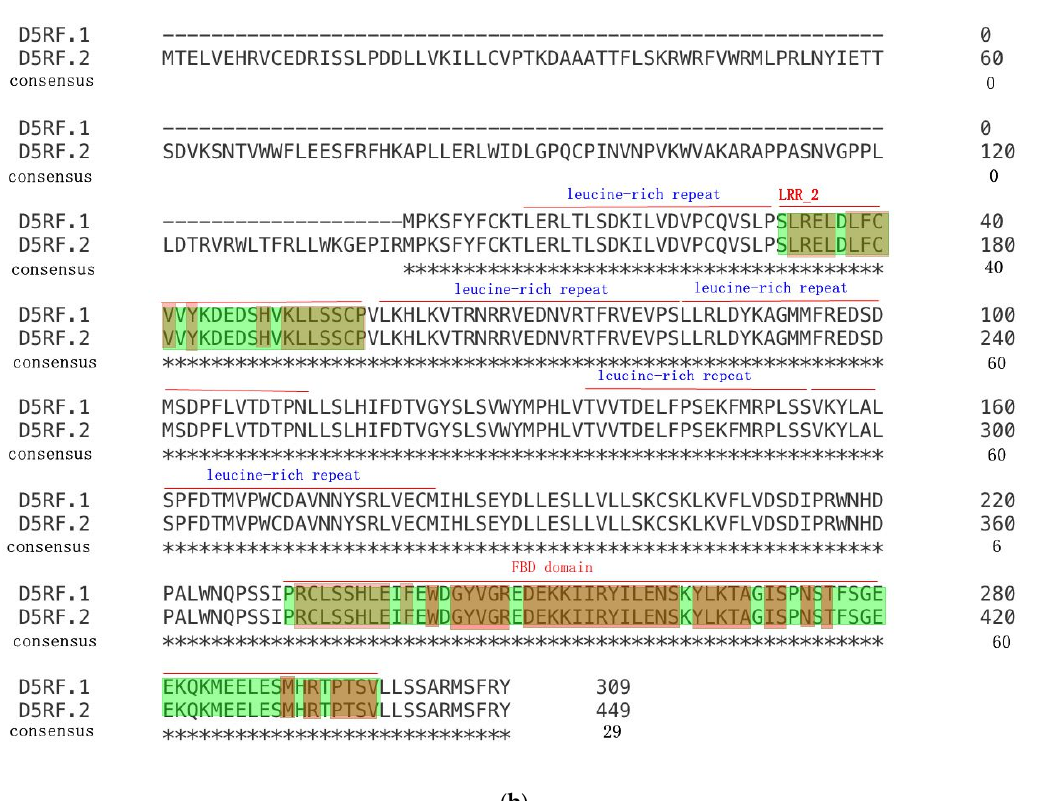
Figure 2. Gene structure and amino acid sequence alignments of the two D5RF open reading frames. ( a ) Schematic representation of the D5RF genomic organization with exons (black boxes) and introns (lines between exons). White boxes indicate the 3′-UTRs. ( b ) Amino acid sequence alignments of the two D5RF. Conservative domains are indicated in green, and important sites are indicated in gold. Int. J. Mol. Sci. 2020 , 21 , x FOR PEER REVIEW